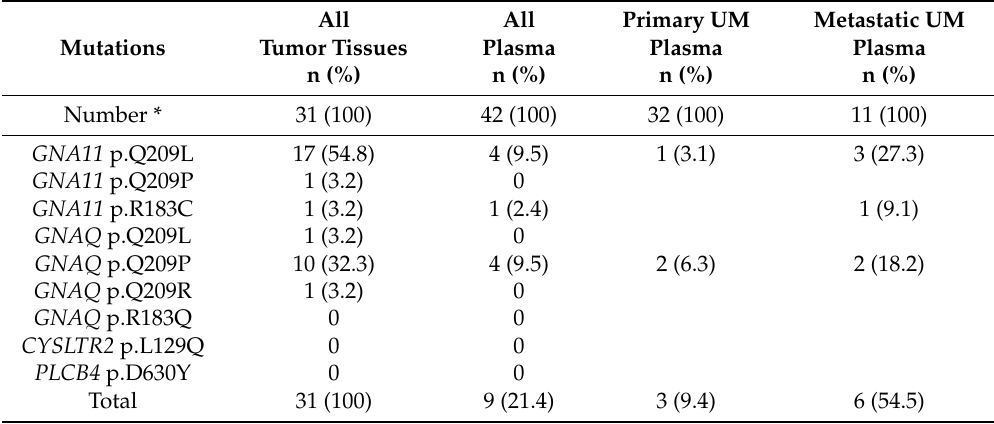
Table 2. The presence of GNA11 , GNAQ , CYSLTR2 , and PLCB4 mutations in tumor tissues and the peripheral blood of primary and metastatic UM